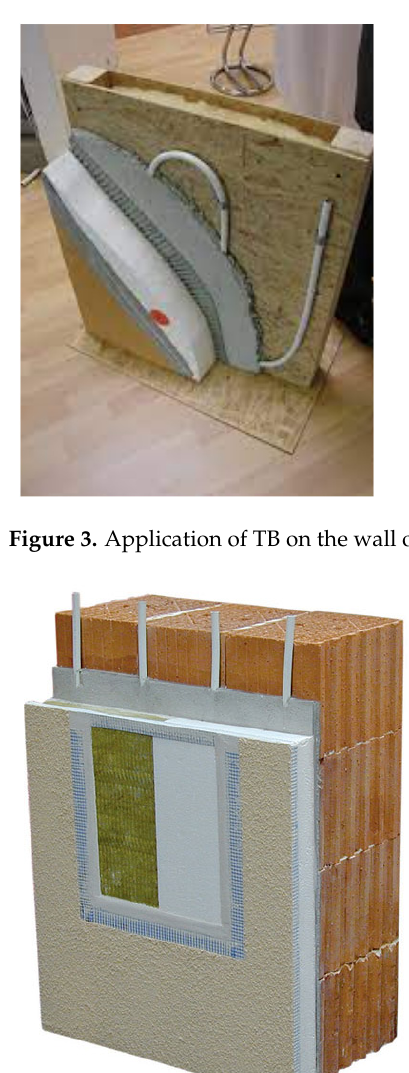
Figure 2. Application of TB on porous concrete block wall [5].